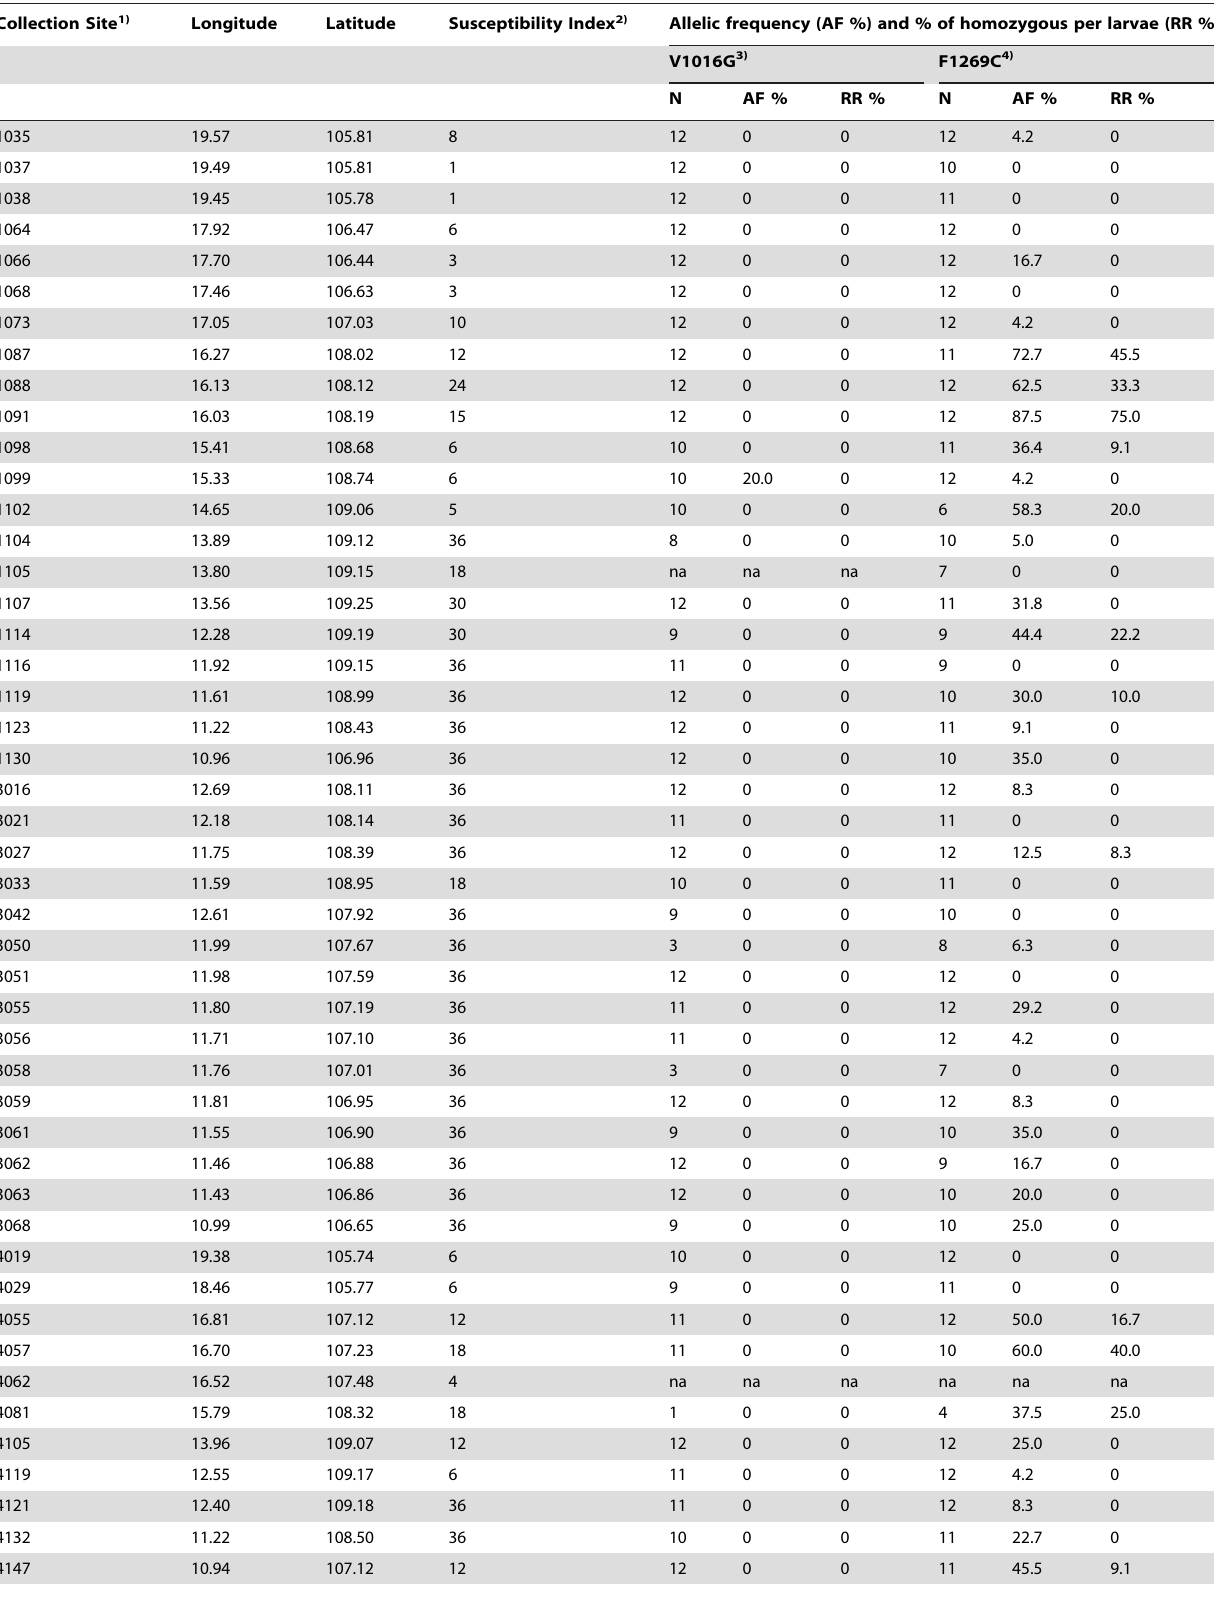
Collection Site